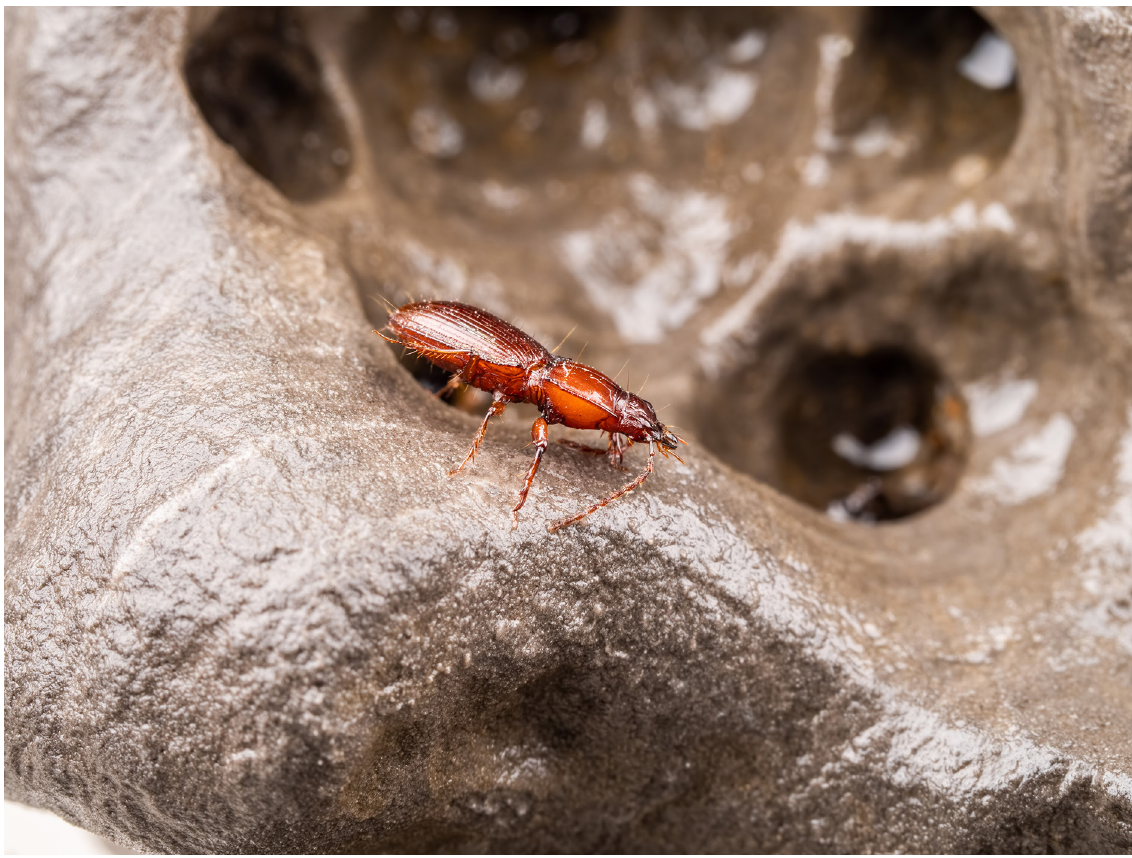
Fig. 11. Guiodytes inexpectatus Tian & Zhou sp. nov., holotype, ♀ (SCAU), found in the Zhuzhu Dong